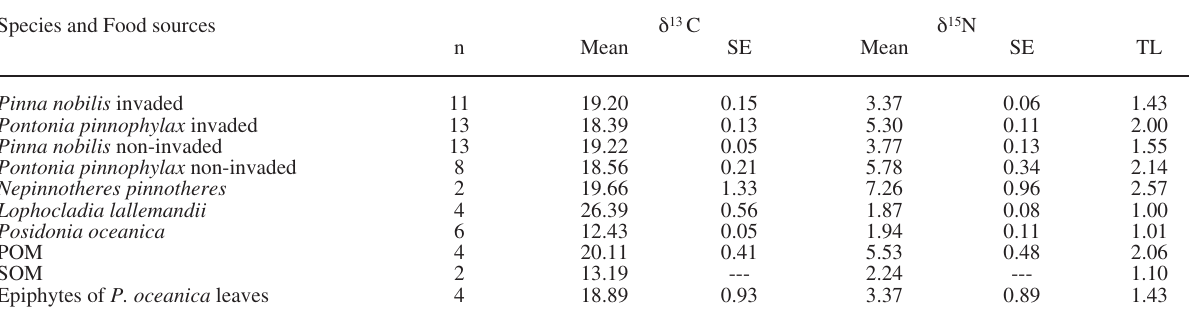
Table 2. – number of samples (n), stable isotopes values ( δ 13 C and δ 15 n) and trophic level (Tl) of the studied species at invaded and non- invaded locations and the food sources. Results are expressed as mean ± standard error (se). PoM, particulate organic matter; soM, sediment organic matter; ---, data